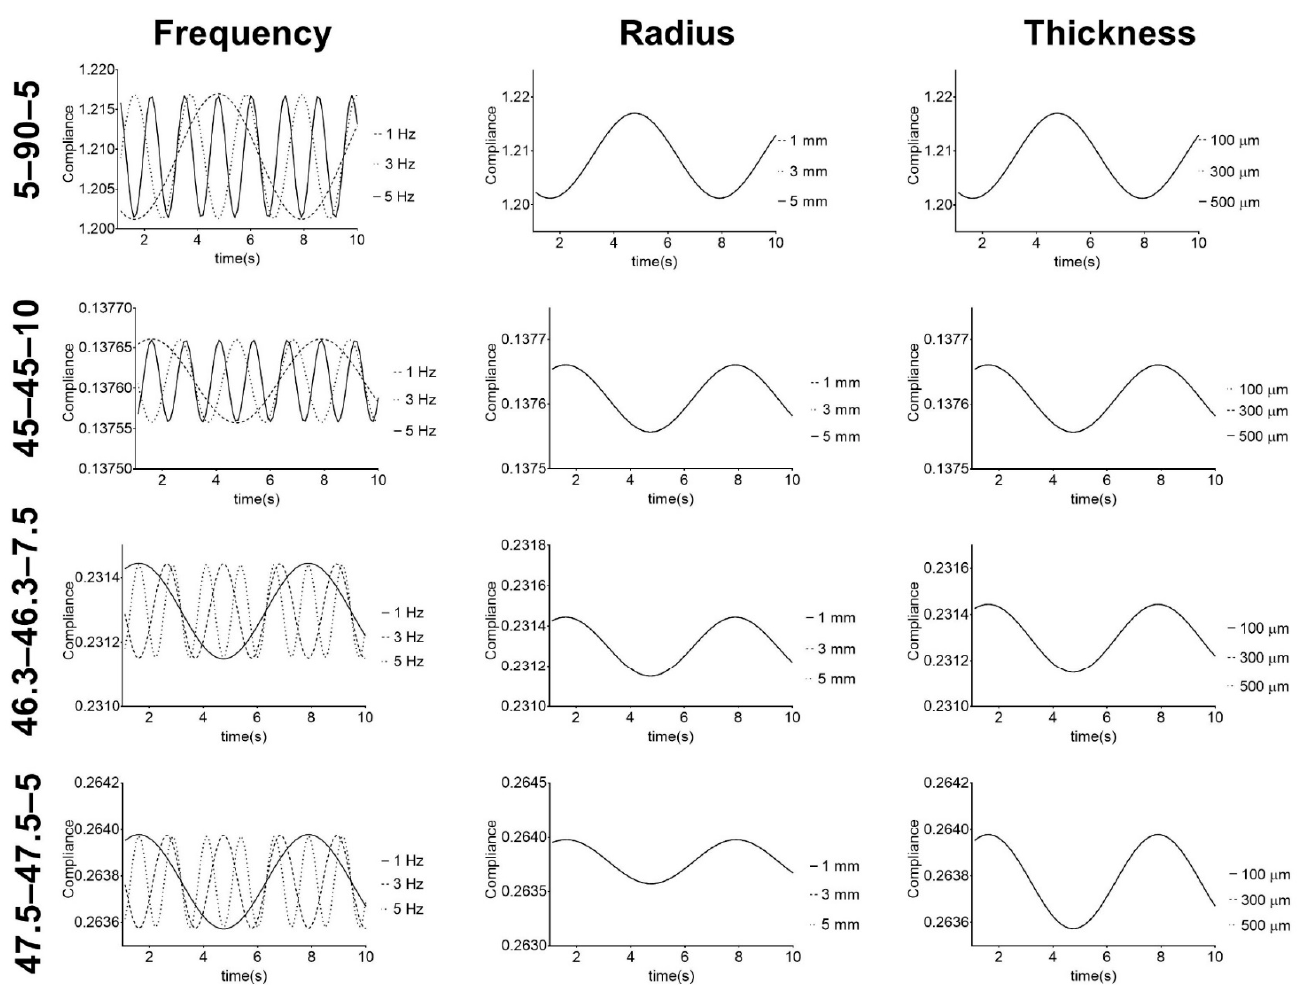
Figure 7. Response of PU-based vascular grafts under simulated physiological mechanical conditions. Compliance given in mmHg − 1 × 10 4 .